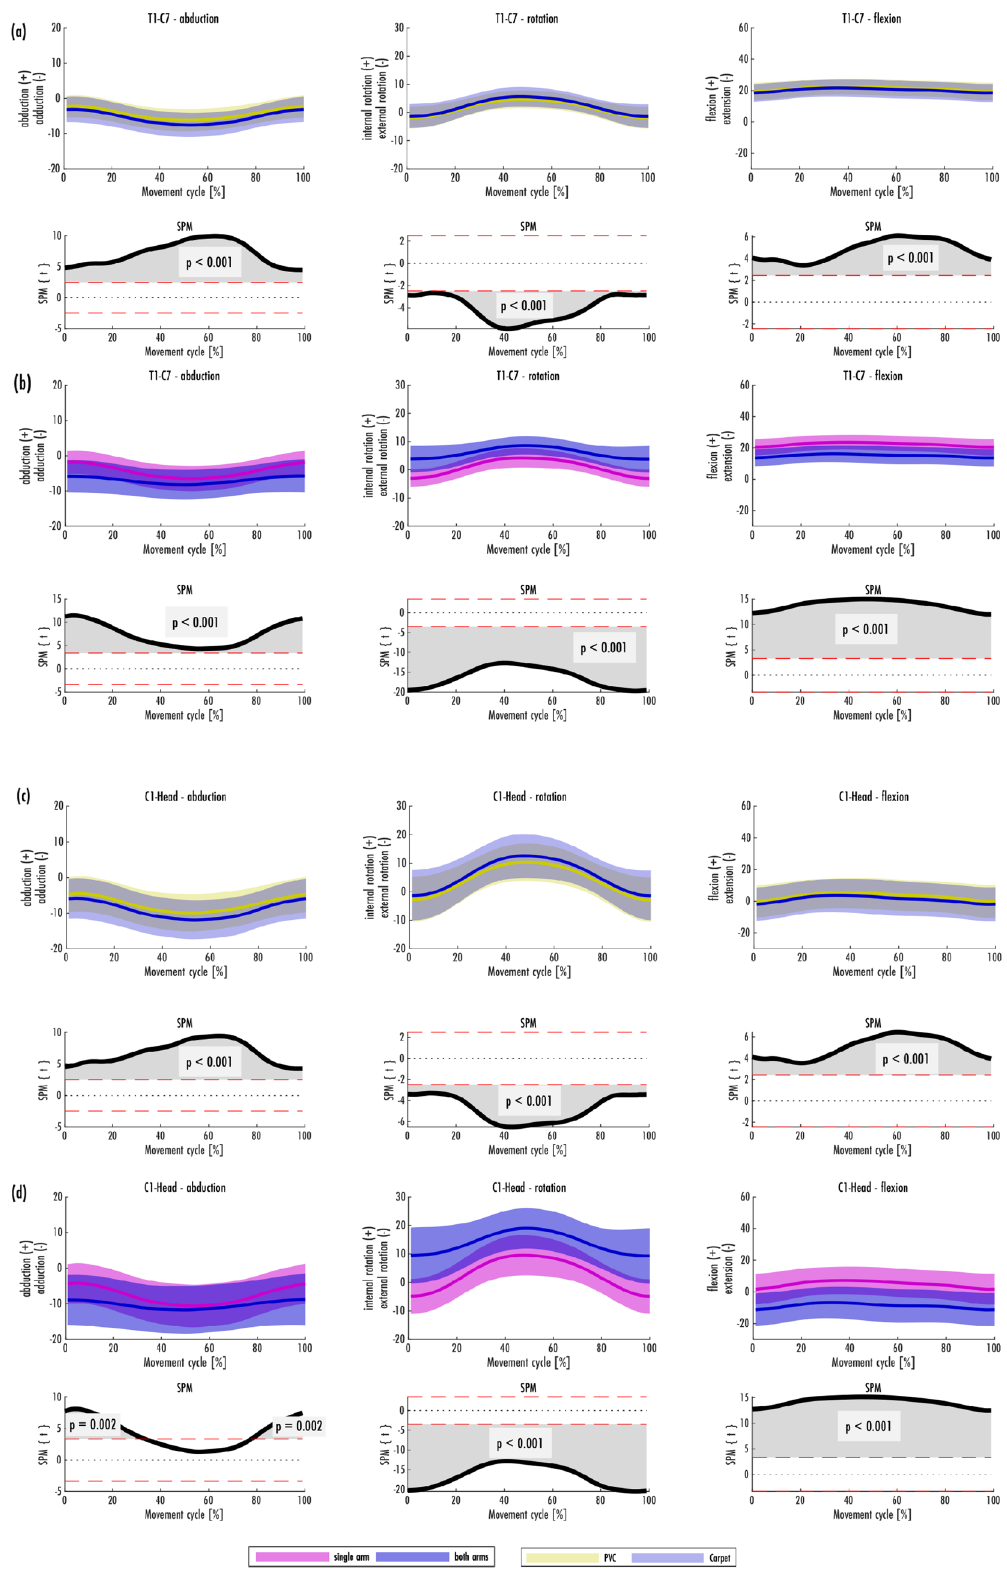
Figure 1. Spinal movements in the areas C1-Head ( a , b ) and T1-C7 ( c , d ) in the habitual vacuuming cycle [mean and range of standard deviation (± SD)]. ( a , c ) are grouped based on the carpet condition, ( b , d ) are grouped based on the grip position. The result of the SPM is plotted directly underneath the mean and SD of the